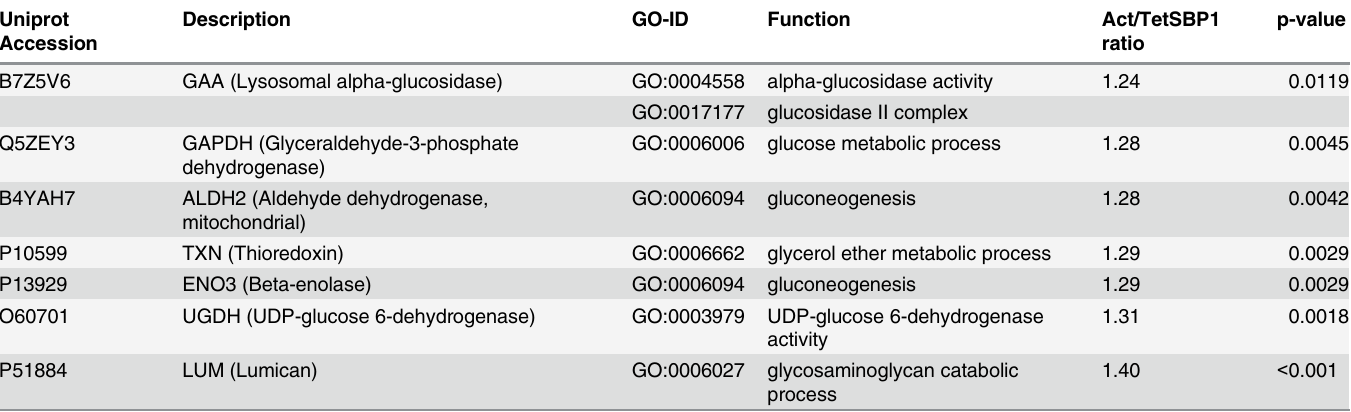
Table 2. Identified differentially accumulated proteins related to glucose